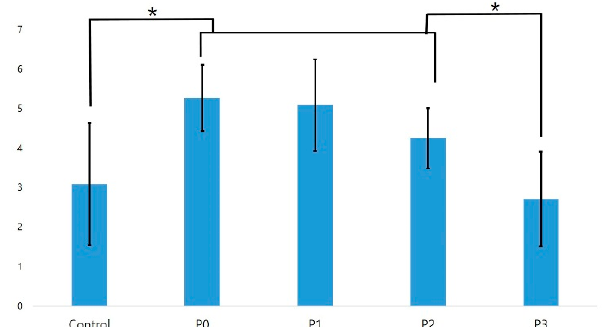
Figure 7. Results of a one-way analysis of variance of the shear bond strength of RelyXTM U200 ( n = 10). An * denotes a significant difference ( p < 0.05).